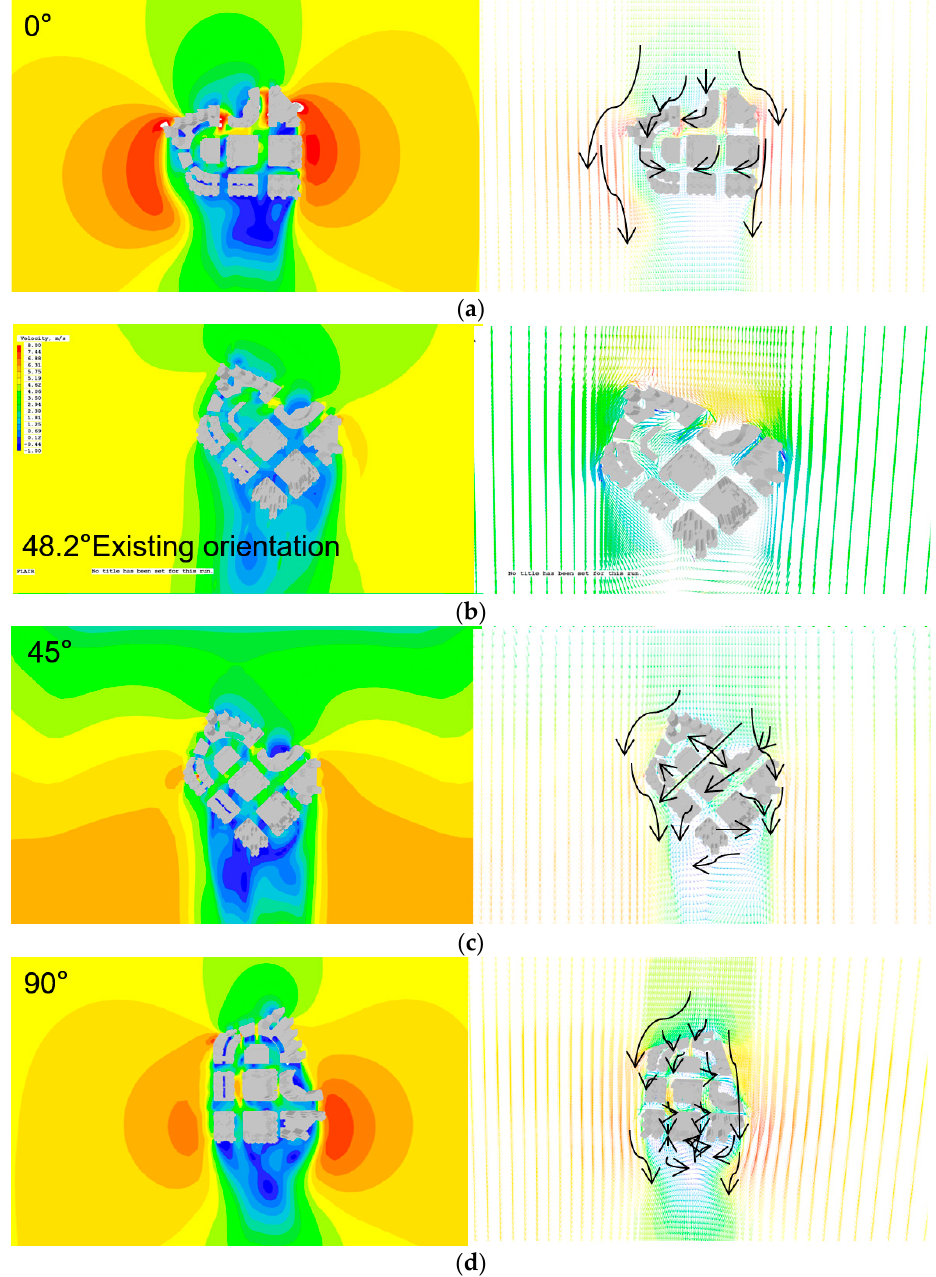
Figure 5. Results of the analysis of wind direction and street orientation. ( a ) Schematic diagram of wind direction and street orientation at 0°; ( b ) Schematic diagram of wind direction and street orientation at 48.2°; ( c ) Schematic diagram of wind direction and street orientation at 45°; ( d ) Schematic diagram of wind direction and street orientation at 90°.